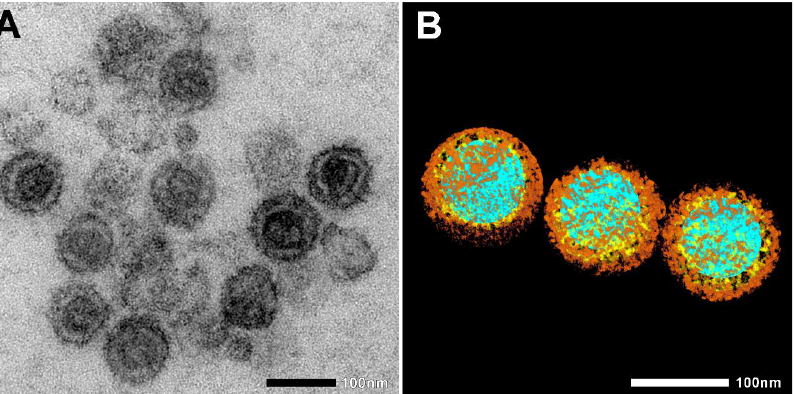
Figure 1. Electron microscopic images of heat-inactivated SARS-CoV-2. ( A ) Native electron micro- scopic image. ( B ) For the visualization of SARS-CoV-2 morphology, regions of interest, such as nucleic acid (blue), nucleocapsid (yellow), and spike proteins (brown), were segmented manually. Scale bar 100 nm. EM nicely revealed the progress of SARS-CoV- 2′ s endocytosis in L929 and RAW cells from surface attachment to endosome engulfment (Figure 2A,B). Thus, EM showed that despite the differences in murine ACE2, inactivated SARS-CoV-2 particles can be bound and internalized by murine cells (Figures 2 and 3 and Supplementary Figure S1).